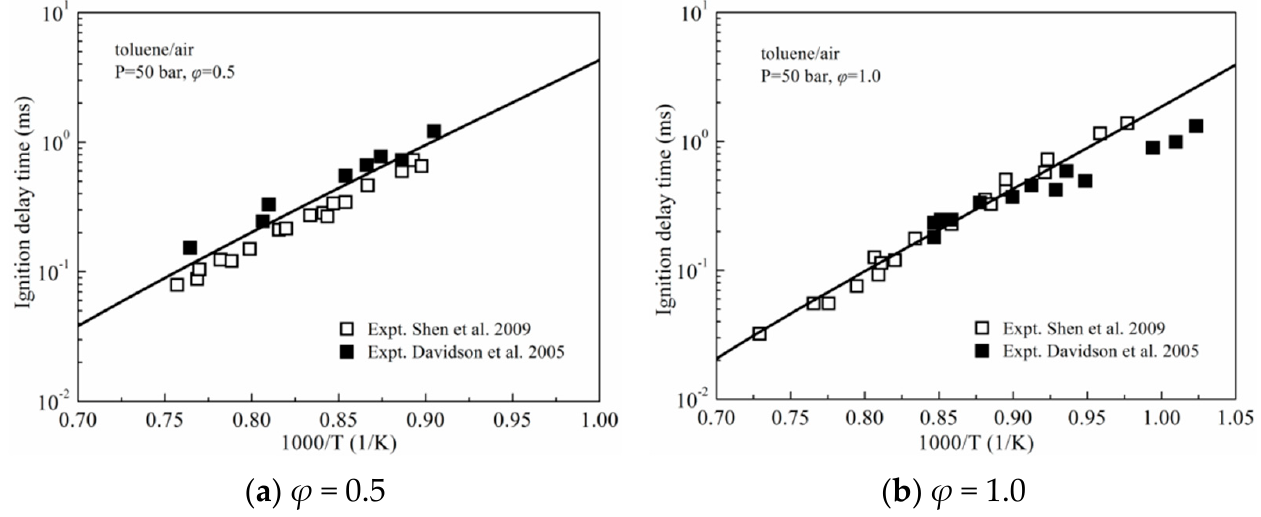
Figure 3. Comparisons between the predicted (lines) and experimental [39,40] (symbols) ignition delays of toluene/air mixtures.